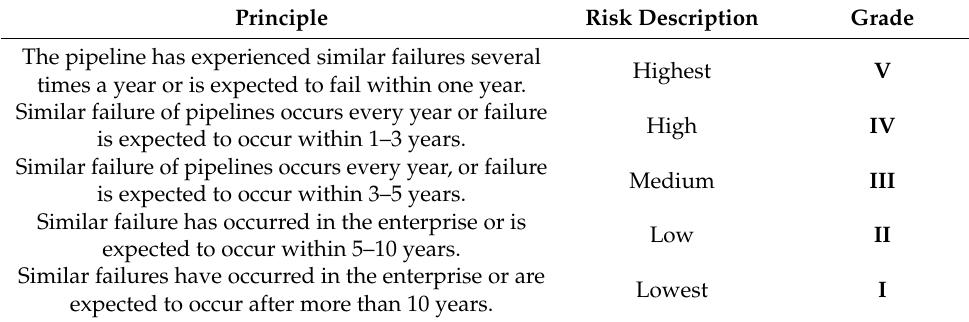
Table 4. Failure probability scoring